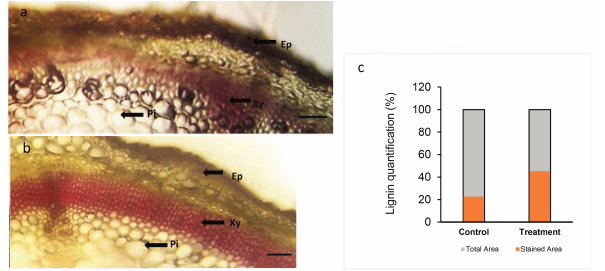
Fig. 4 ­ Microscopic view of stained cross sections after 14 days of rubbing of the third internode for control (a) interno­ de stressed (b) and graph showing quantification of lignin analysis by ImageJ software (c). Ep­epidermis, Xy­ xylem (lignin deposition) and Pi­pith. Scale bar = 100 µm.